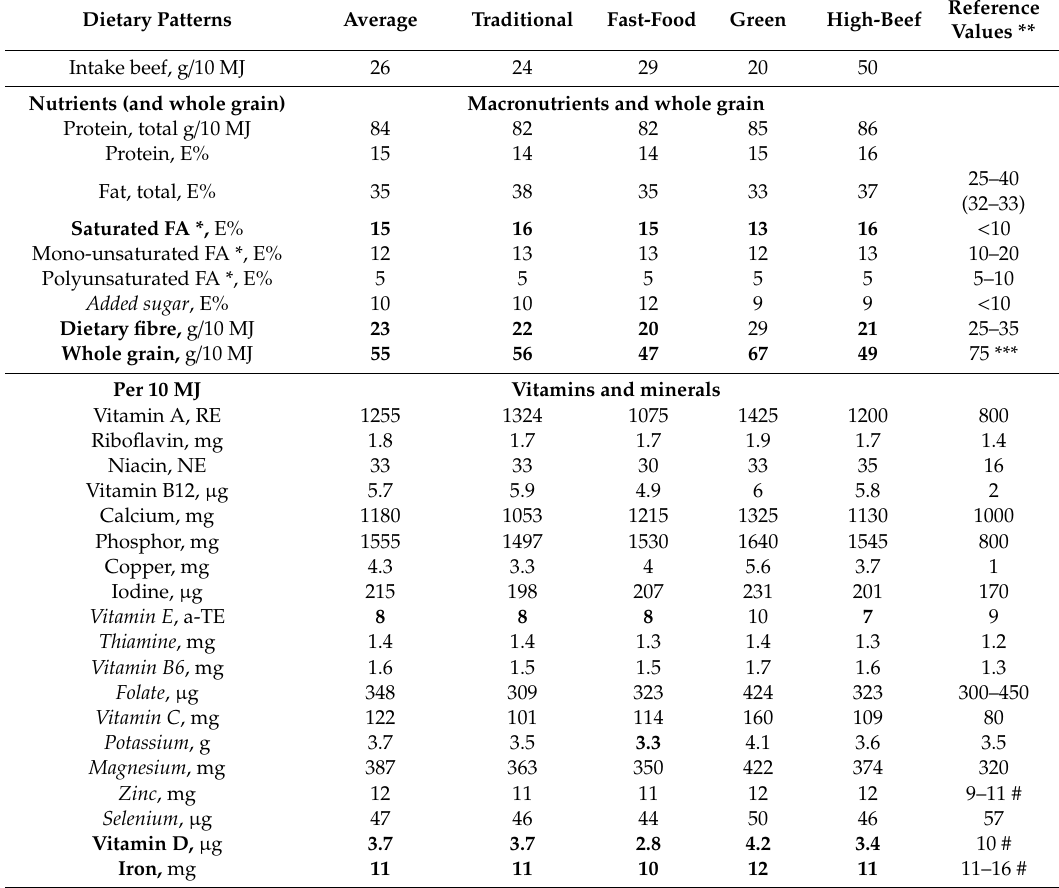
Table 6. Nutritional profile in di ff erent dietary patterns and indications of nutrients / diet-characteristics that are to be improved (bold) or at least maintained by a change of the diet